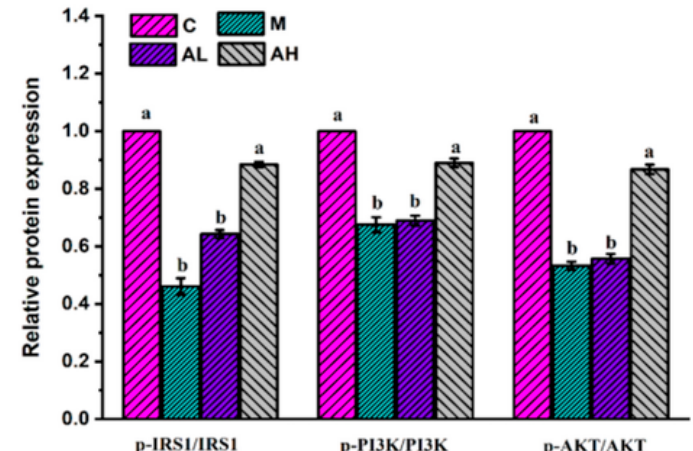
Figure 5. The effect of ethanol extract from R. chinensis Mill. fruits on the expression of several key proteins related to glycometabolism in the liver, including insulin receptor substrate-1(IRS1), phosphorylated insulin receptor substrate-1 (p-IRS1), phosphatidylinositol 3 kinase (PI3K), phosphorylated phosphatidylinositol 3 kinase(p-PI3K), protein kinase B(AKT), and phosphorylated protein kinase B (p-AKT). ( A , B ) represent the glucose pathways and the relative quantity of protein, respectively. The relative expressions of above proteins were quantified by normalization with group C and compared with β -actin. C: Control group, M: Model group, AL: Low dose ethanol extract group (200 mg/kg), AH: High dose ethanol extract group (600 mg/kg). Data were expressed as the mean ± SE ( n = 6). Different letters indicate significant differences ( p < 0.05).